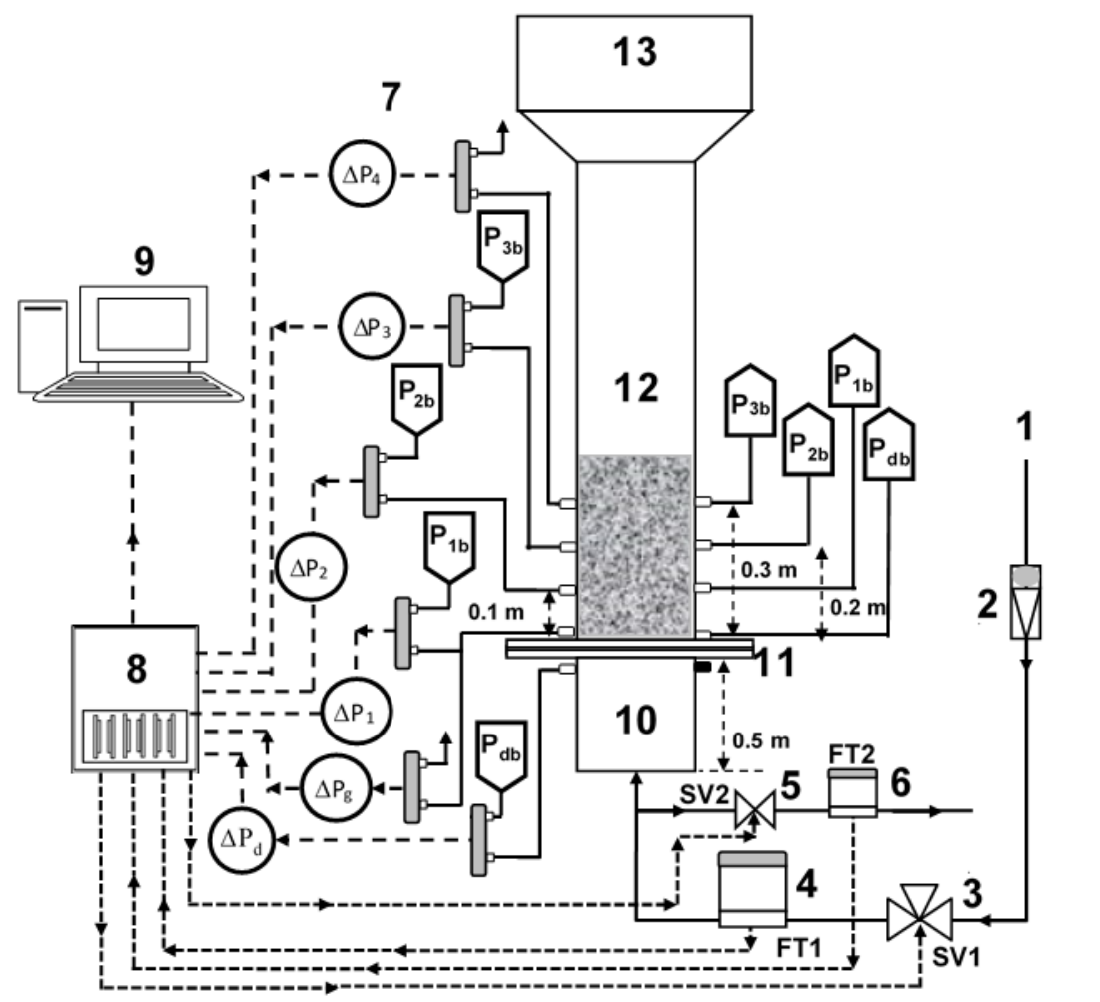
Figure 1. Experimental set-up schematic; (1) Air supply; (2) Flowmeters; (3) 3-way solenoid valve; (4) Flow totalizer; (5) 2-way solenoid valve; (6) Flow totalizer; (7) Pressure transducers; (8) Data acquisition system; (9) Computer; (10) Calming section; (11) Distributor; (12) Test section; (13) Disengagement section.